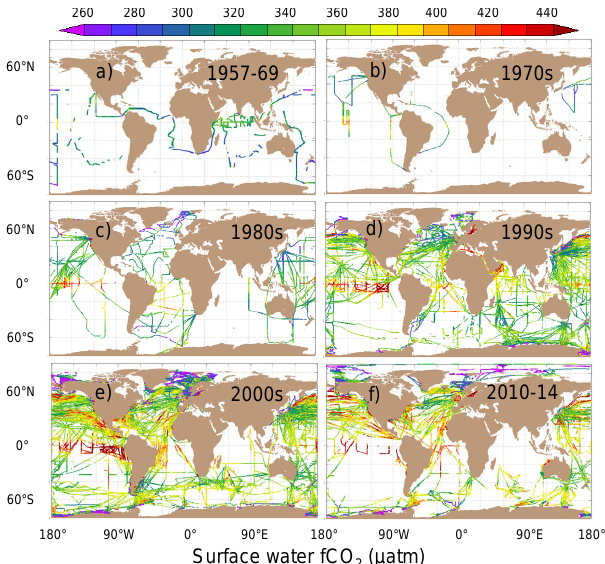
Figure 3. Decadal distribution of surface water f CO 2 (µatm) for the global oceans and coastal seas in SOCAT version 3: (a) 1957 through 1969, (b) 1970s, (c) 1980s, (d) 1990s, (e) 2000s, and (f) 2010 through 2014. Similar figures are available for versions 1 and 2 (Pfeil et al., 2013; Brévière et al., 2015).